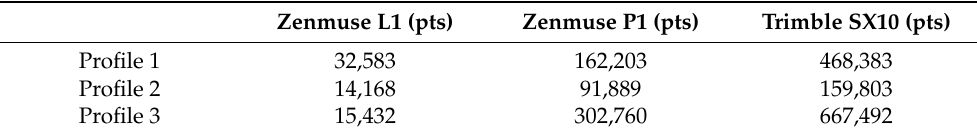
Figure 17. Profile 3 on the z axis, slicing only the castle at 11.50 m from the terrain level. Table 11. Point cloud data of aerial and terrestrial sensors related to extracted sections.